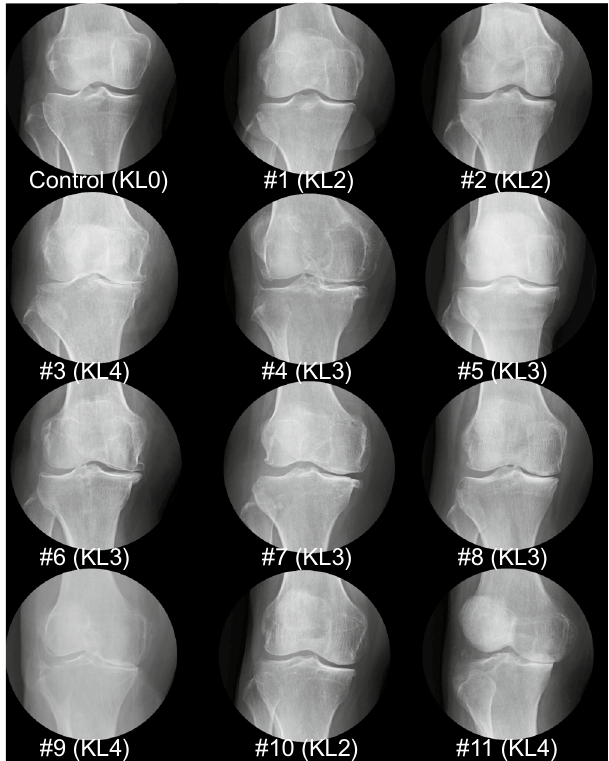
Figure 3. Anteroposterior radiographic images of the knee in the standing position. The images are ordered from highest to lowest in terms of their cartilage area ratios at the medial tibia. The Kellgren–Lawrence grade is also